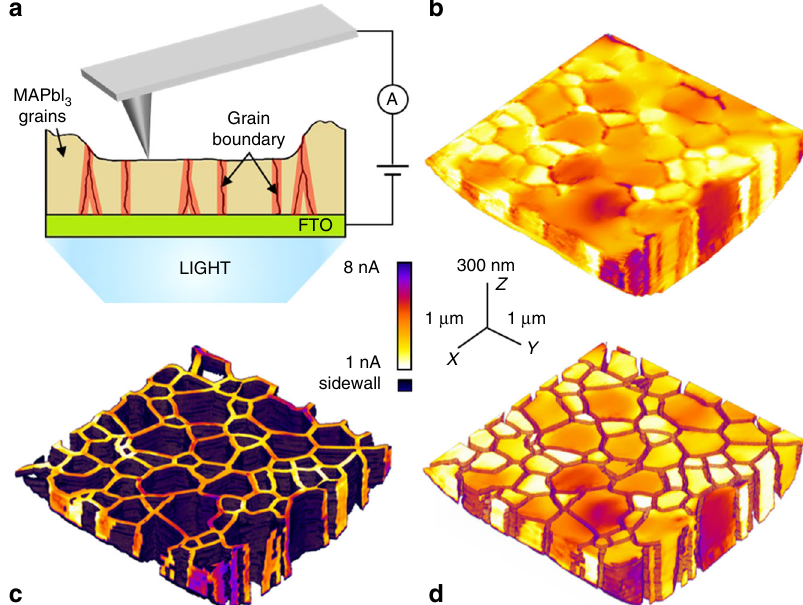
Fig. 1 Fully 3D photocurrent mapping throughout polycrystalline MAPbI 3 thin fi lms. a Schematic illustration of photoconductive T-AFM with bottom illumination of polycrystalline MAPbI 3 thin fi lm. b Volumetric perspective of photocurrent distribution throughout MAPbI 3 thin fi lm by T-AFM. c – d Volumetric perspectives of photocurrent segmented along 3D GB network ( c ) and 3D grains ( d ). ( b ) – ( d ) share the same scale bars and linear-scale color contrast